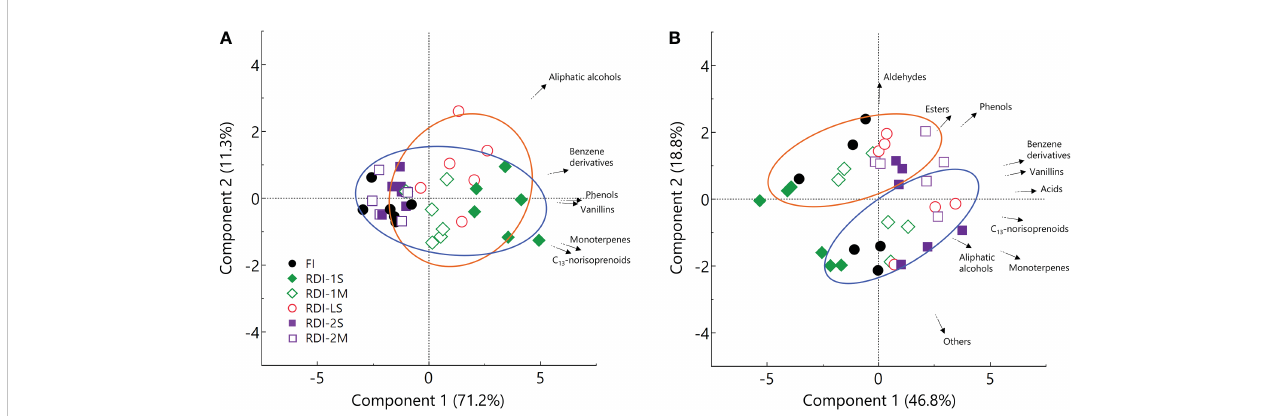
FIGURE 2 Principal component analysis performed on glycosylated (A) and free (B) VOCs from the 2019 (blue centroid) and 2020 (orange centroid) dataset, of berries of Sangiovese ( Vitis vinifera L.) grapevines subjected to six different irrigation regimes (FI, full irrigation from berry pea size to harvest; RDI-1S and RDI-1M, severe and moderate water de fi cit applied from berry pea size to beginning of veraison; RDI-LS, water de fi cit applied during lag phase; RDI-2S and RDI-2M, severe and moderate water de fi cit applied from beginning of veraison to harvest). Each symbol represents one